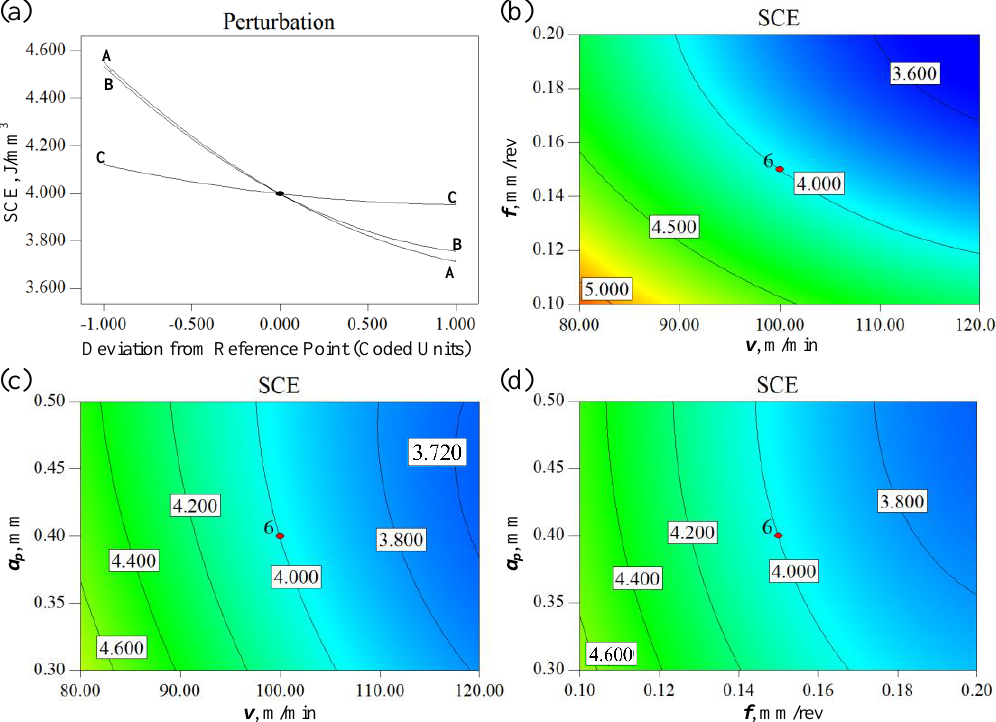
Figure 11. E ff ect of cutting parameters on SCE. ( a ) Perturbation plot of the e ff ect of cutting parameters Figure 11. Effect of cutting parameters on SCE. ( a ) Perturbation plot of the effect of cutting on SCE, ( b ) contour plot of the e ff ect of cutting speed and feed on SCE, ( c ) contour plot of the e ff ect of parameters on SCE, ( b ) contour plot of the effect of cutting speed and feed on SCE, ( c ) contour plot cutting speed and depth of cut on SCE, ( d ) contour plot of the e ff ect of feed and depth of cut on of the effect of cutting speed and depth of cut on SCE, ( d ) contour plot of the effect of feed and depth of cut on SCE.